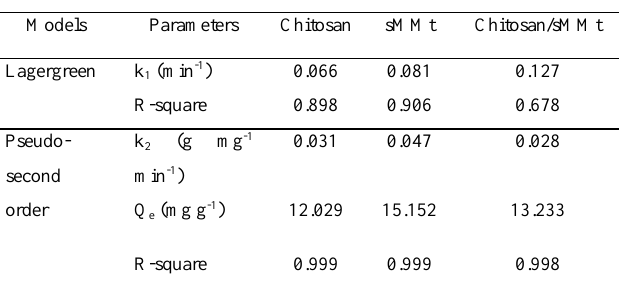
Table 1. Kinetic parameters resulted from plotting Lagergren and